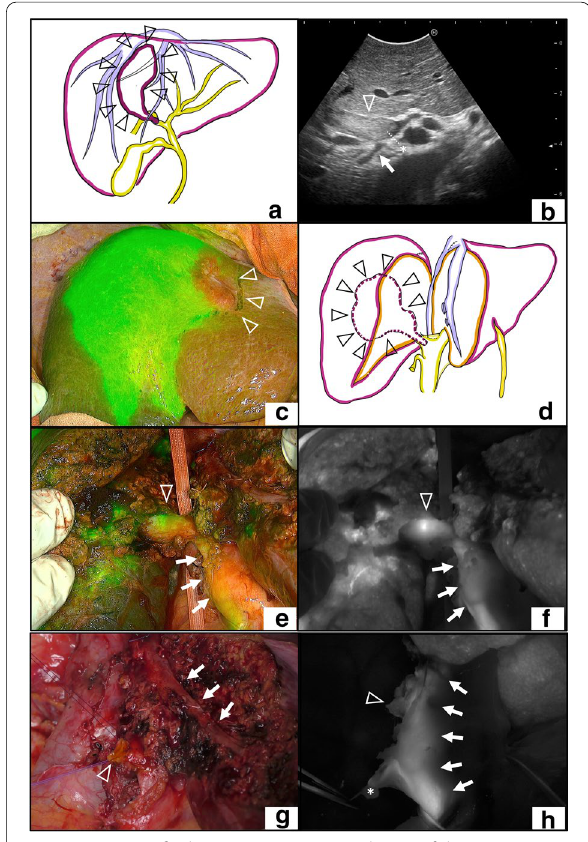
Fig. 3 Operative findings. a Preoperative scheme of the patient. Triangle: tumor. b Indocyanine green (ICG) fluorescence imaging. Right anterior section demonstrated evident fluorescence. Arrow head: serosal deformity from tumor. c Intraoperative ultrasonography. The tip of the bile duct tumor thrombus (BDTT) located at the hepatic side of the right hepatic duct. Arrow head: the bile duct of the right anterior branch. Arrow: the posterior branch, Asterisk: the tip of BDTT. d Intraoperative scheme after division of liver parenchyma. Triangle: tumor. e , f ICG fluorescence imaging before the division of the right hepatic duct. The light of emission from the bile duct and BDTT with clear contrast; the proximal side of the right hepatic duct exhibited stronger fluorescence than the proximal side. Arrow head: location of the BDTT tip in the right hepatic duct. Arrow: common hepatic duct. g After the removal of surgical specimen. Arrow head: stump of the right hepatic duct. Arrow: middle hepatic vein. h ICG fluorescence imaging of the bile duct after resection. Bile duct route from the left hepatic duct to the common hepatic duct is clearly visualized. Arrow head: stump of the right hepatic duct. Arrow: Bile duct route from the left hepatic duct to the common hepatic duct. Asterisk: stump of cystic